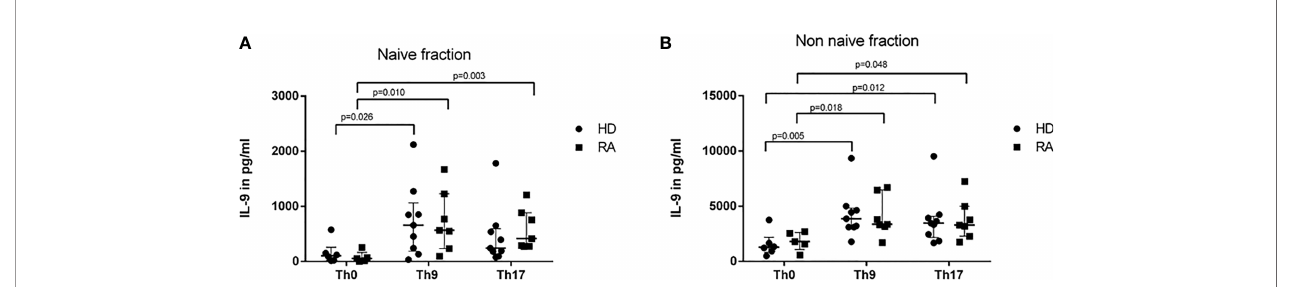
FIGURE 2 | IL-9 concentrations in supernatants of naive (A) and non-naive CD4+ cells (B) after 3 days cultures with control conditions (Th0) and Th9- or Th17- stimulus in healthy donors (HD) and rheumatoid arthritis (RA) patients. Concentrations of IL-9 were measured in supernatants of naive (A) and non-naive CD4+ T cells (B) which were culture in control conditions (Th0) and in Th9- or Th17-stimulating cytokine conditions in rheumatoid arthritis (RA) patients and healthy donors (HD)